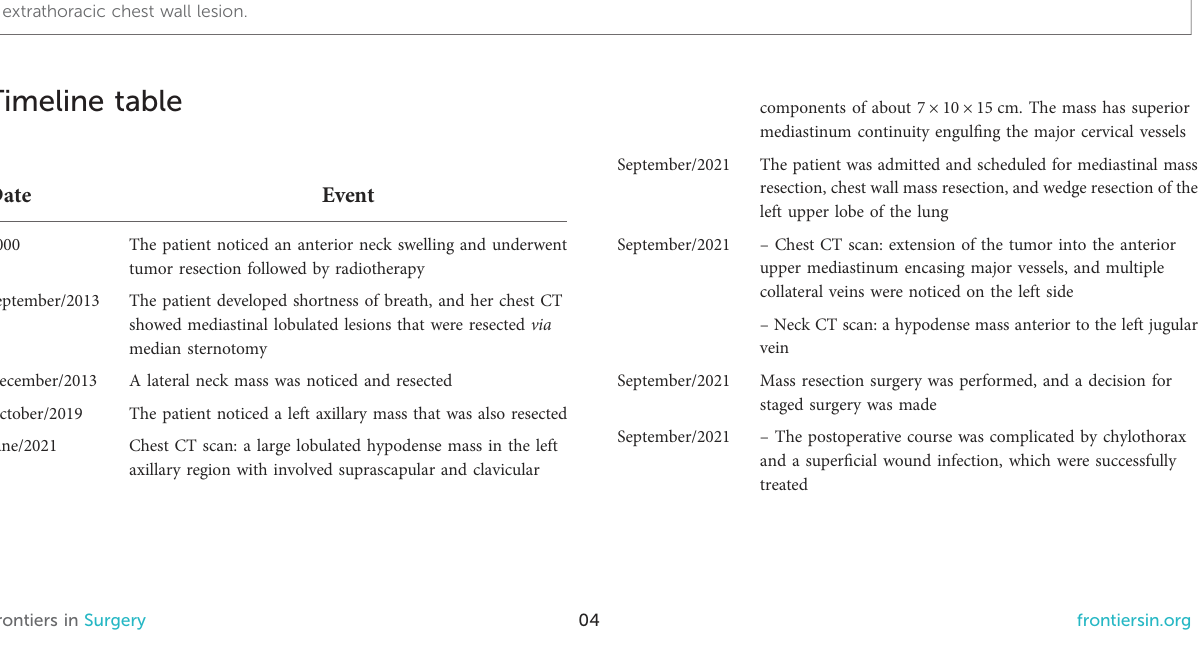
FIGURE 2 Panel ( A ) and ( B ) are CT scans done pre-operatively on 4/9/2021. Panel ( C ) is an MRI done pre-operatively on 8/9/2021. The fi gure shows a large anterior mediastinal mass engul fi ng the arch of the aorta and its branches. Red arrows indicate the mediastinal lesion, yellow arrow indicates the extrathoracic chest wall